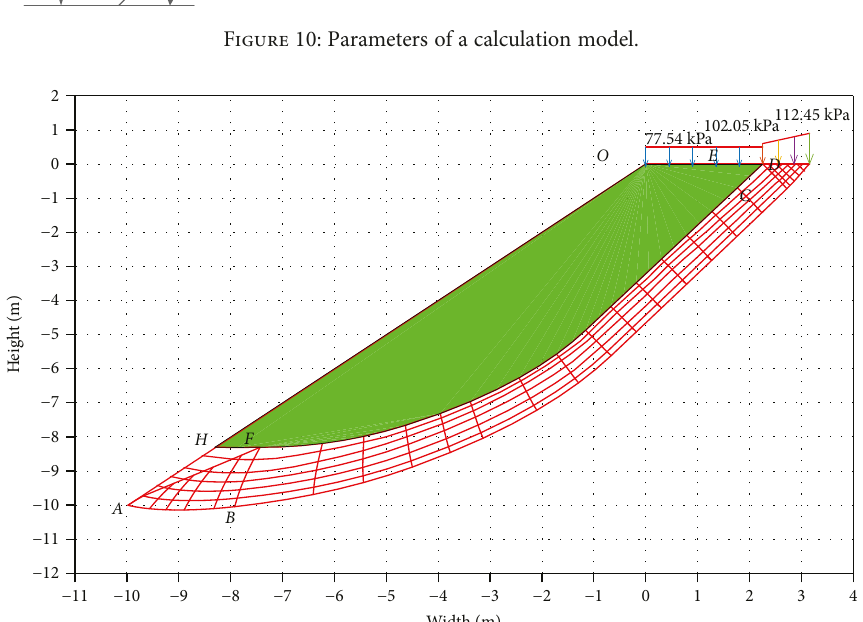
Figure 11: Distribution of the sliding belt and ultimate loads under the limit